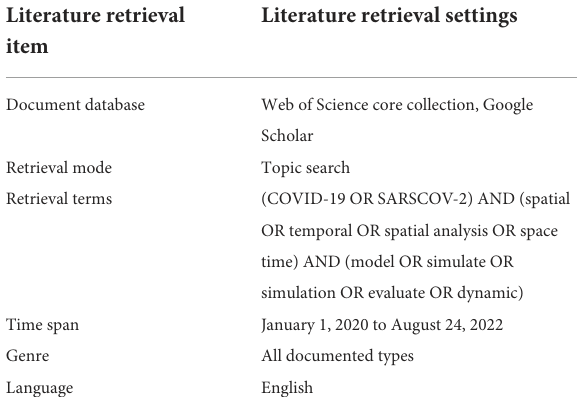
TABLE 2 Literature data retrieval condition settings such as document database, retrieval mode, retrieval terms, time span, genre and language in this